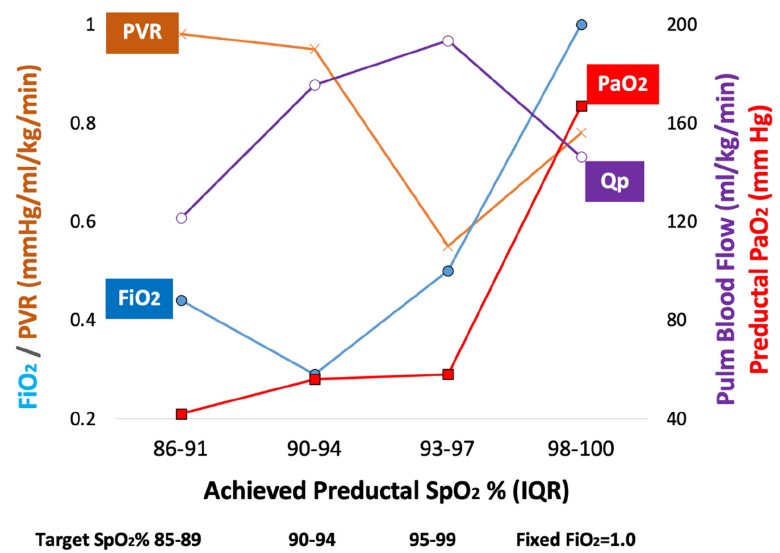
Figure 1. Oxygen saturations targets (SpO 2 ), fraction inspired oxygen (F i O 2 ), pulmonary vascular resistance (PVR), pulmonary blood flow (Qp), preductal partial arterial oxygen tension (PaO 2 ) and achieved SpO 2 (interquartile range—IQR) in lambs with meconium aspiration. The horizontal axis demonstrates the achieved preductal SpO 2 ranges and interquartile ranges (IQR) closest to the figure and then the target SpO 2 range just below the achieved ranges. Modified from Lakshminrusimha S., Keszler M., Chapter 34, Diagnosis and management of persistent pulmonary hypertension in assisted ventilation of the neonate, 7th edition, 2021. Copyright Satyan Lakshminrusimha .